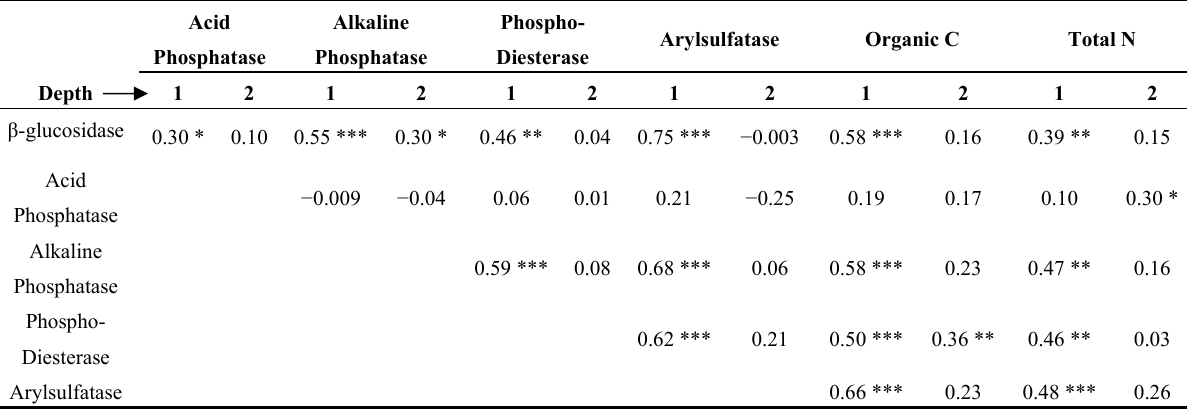
Table 3 . Correlation coefficients between enzyme activities and selected soil